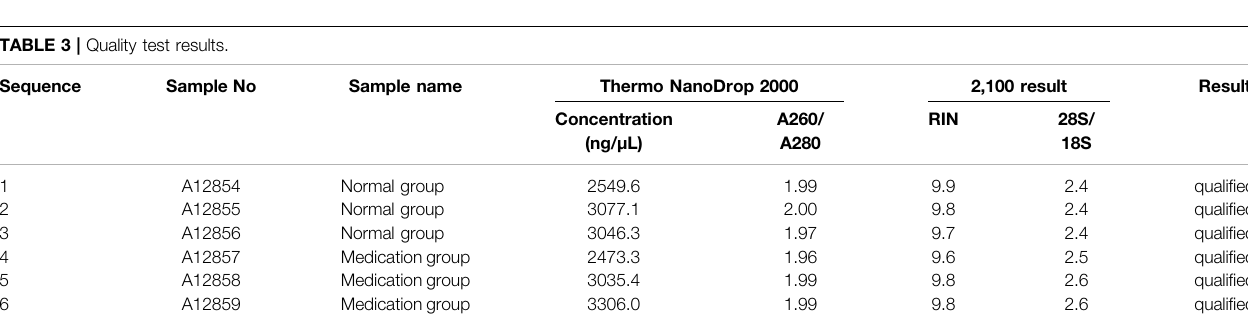
TABLE 3 | Quality test